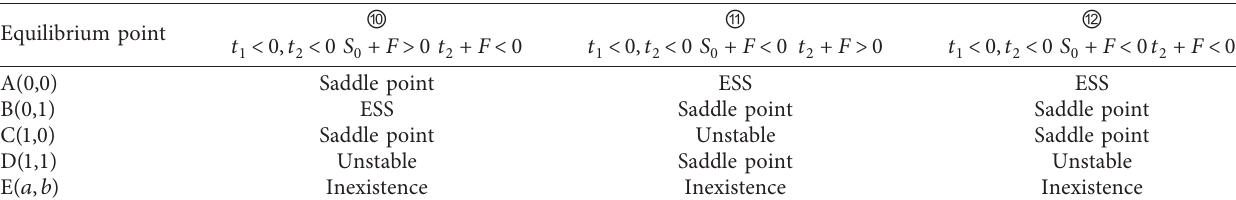
Table 10: Local stability of each equilibrium point in the range of different parameter